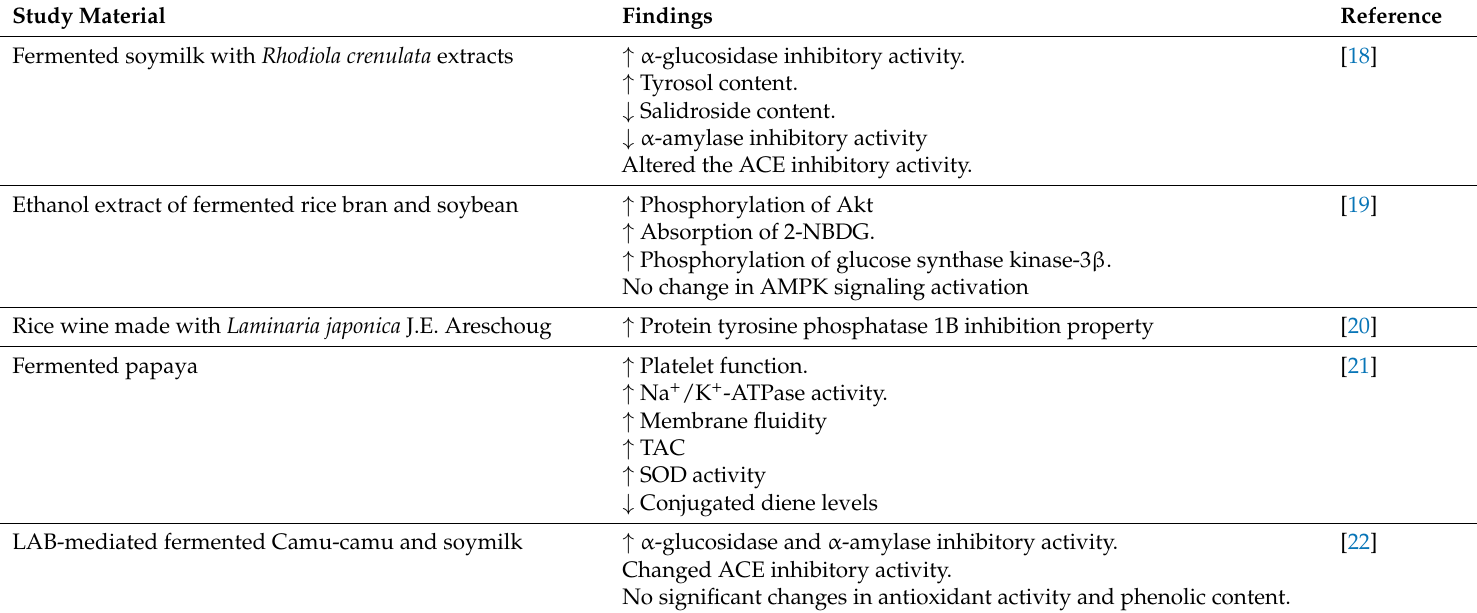
Table 1. Reported in vitro studies revealing the antidiabetic properties of fermented